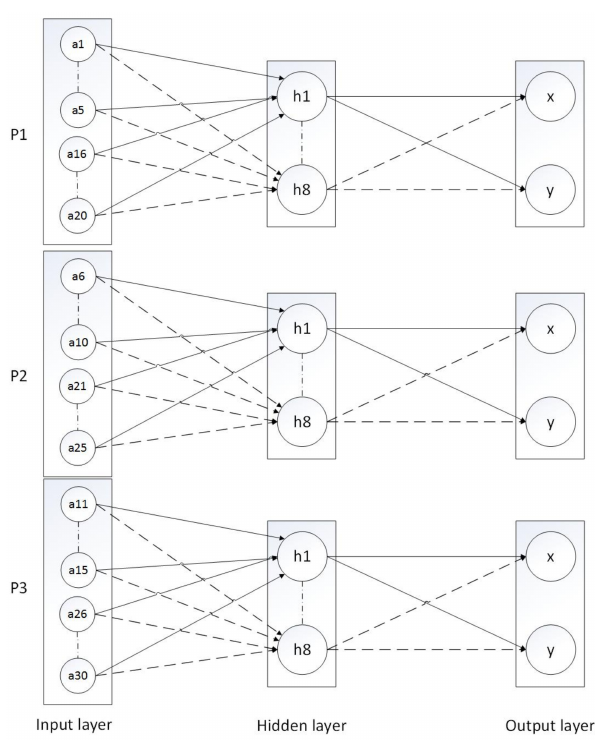
Figure 15. Scheme of Levenberg–Marquardt Hidden-Layer Partition (LM-HLP) neural